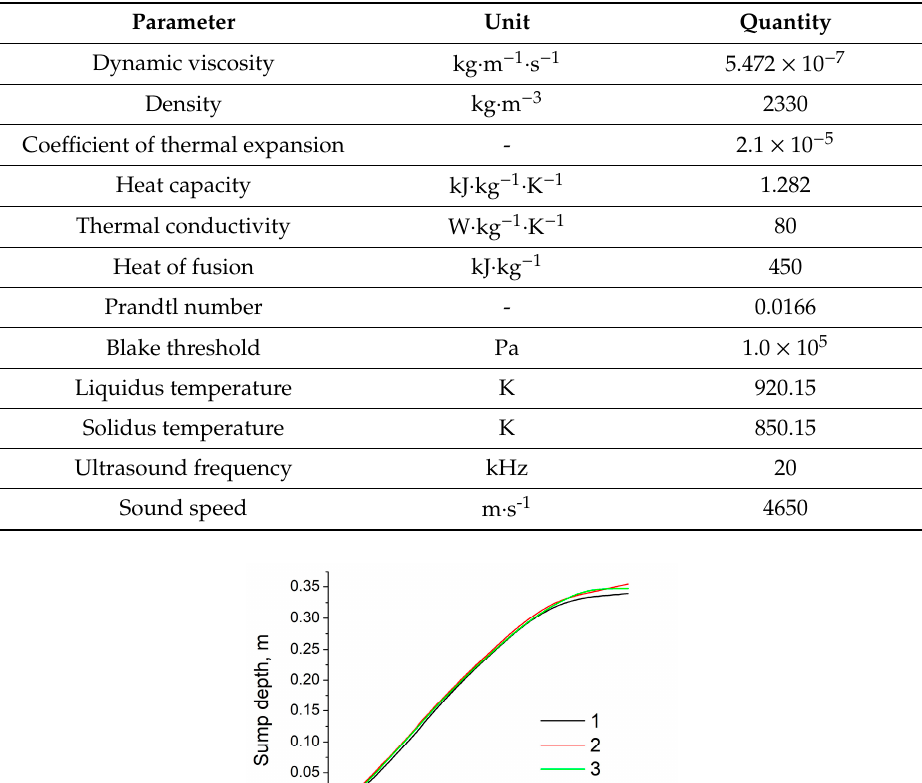
Table 1. Model parameters used for the DC casting simulation.